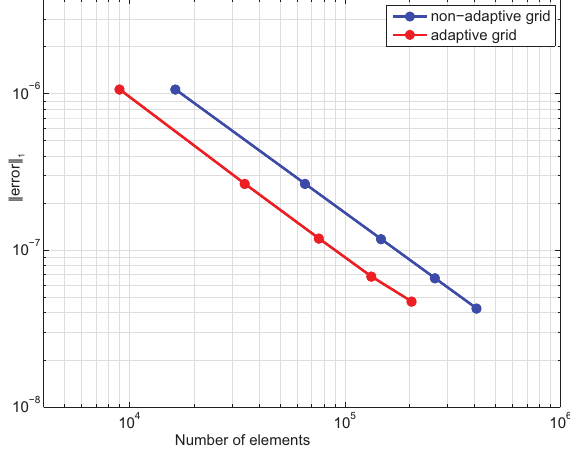
Figure 11. Dependence of the normalized error (cid:107) error (cid:107)